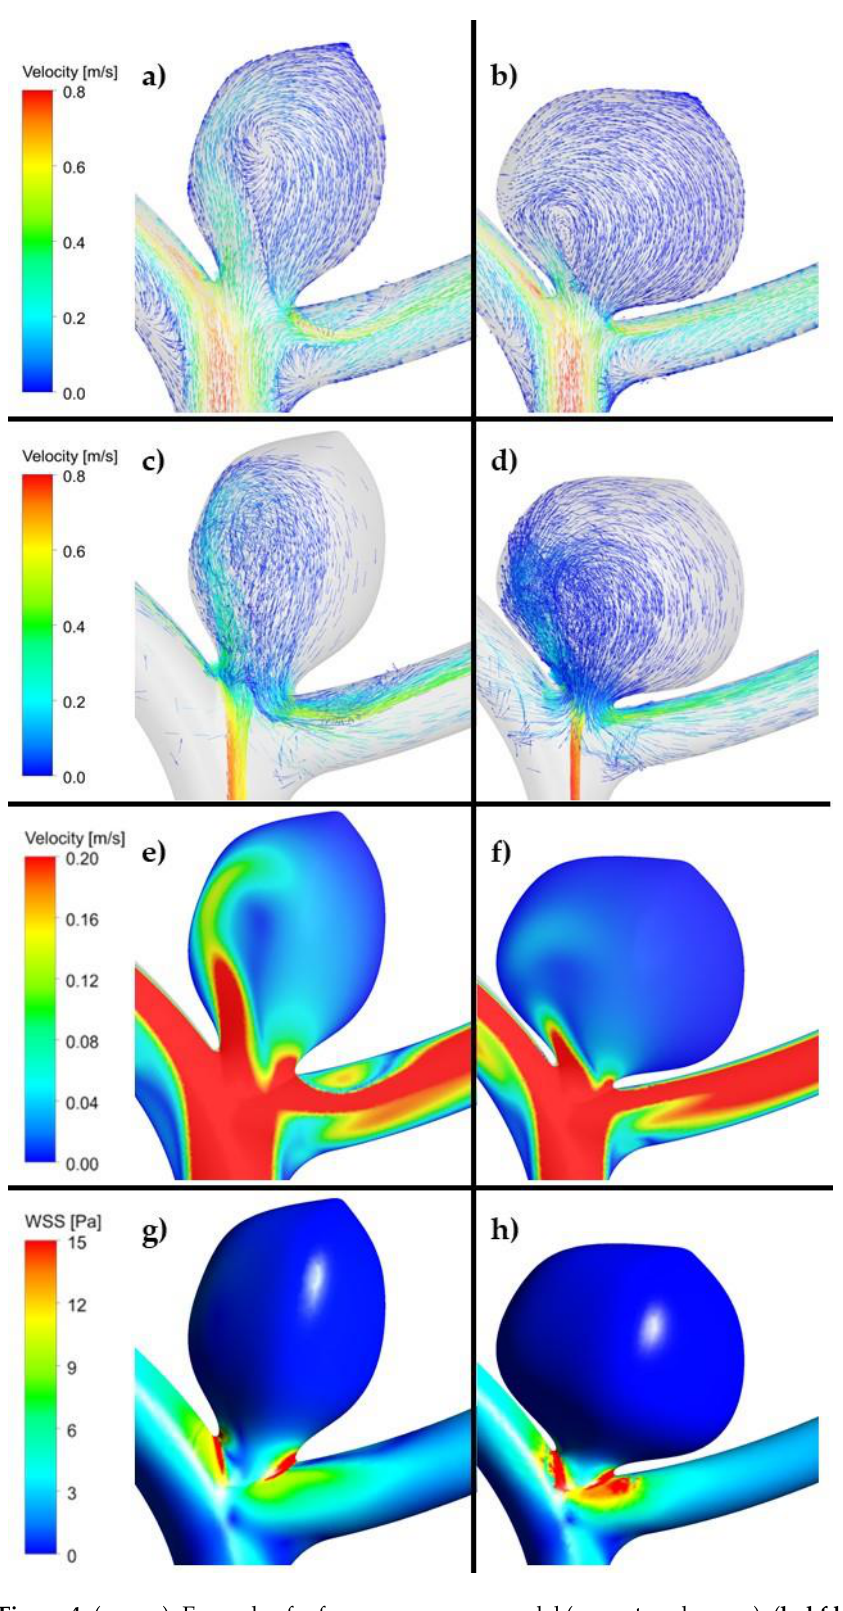
Figure 4. ( a , c , e , g ). Example of reference aneurysm model (unruptured group). ( b , d , f , h ). Example of reference aneurysm model (ruptured group). (ANSYS Inc. Post-processing module, Canonsburg, PA, USA) .